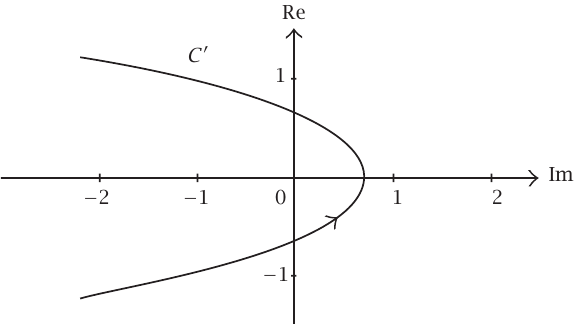
Figure 2.1 . The contour of integration for the Mittag-Leffler function E µ (z) .